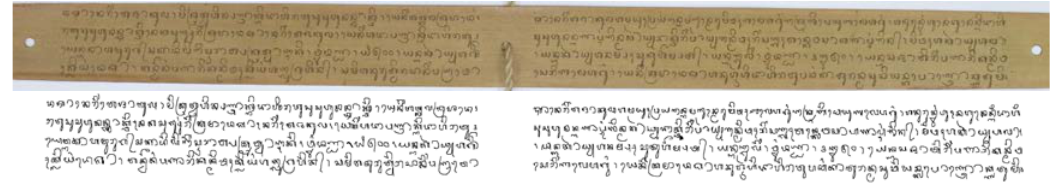
Figure 11. Khmer manuscript with binarized ground truth image.